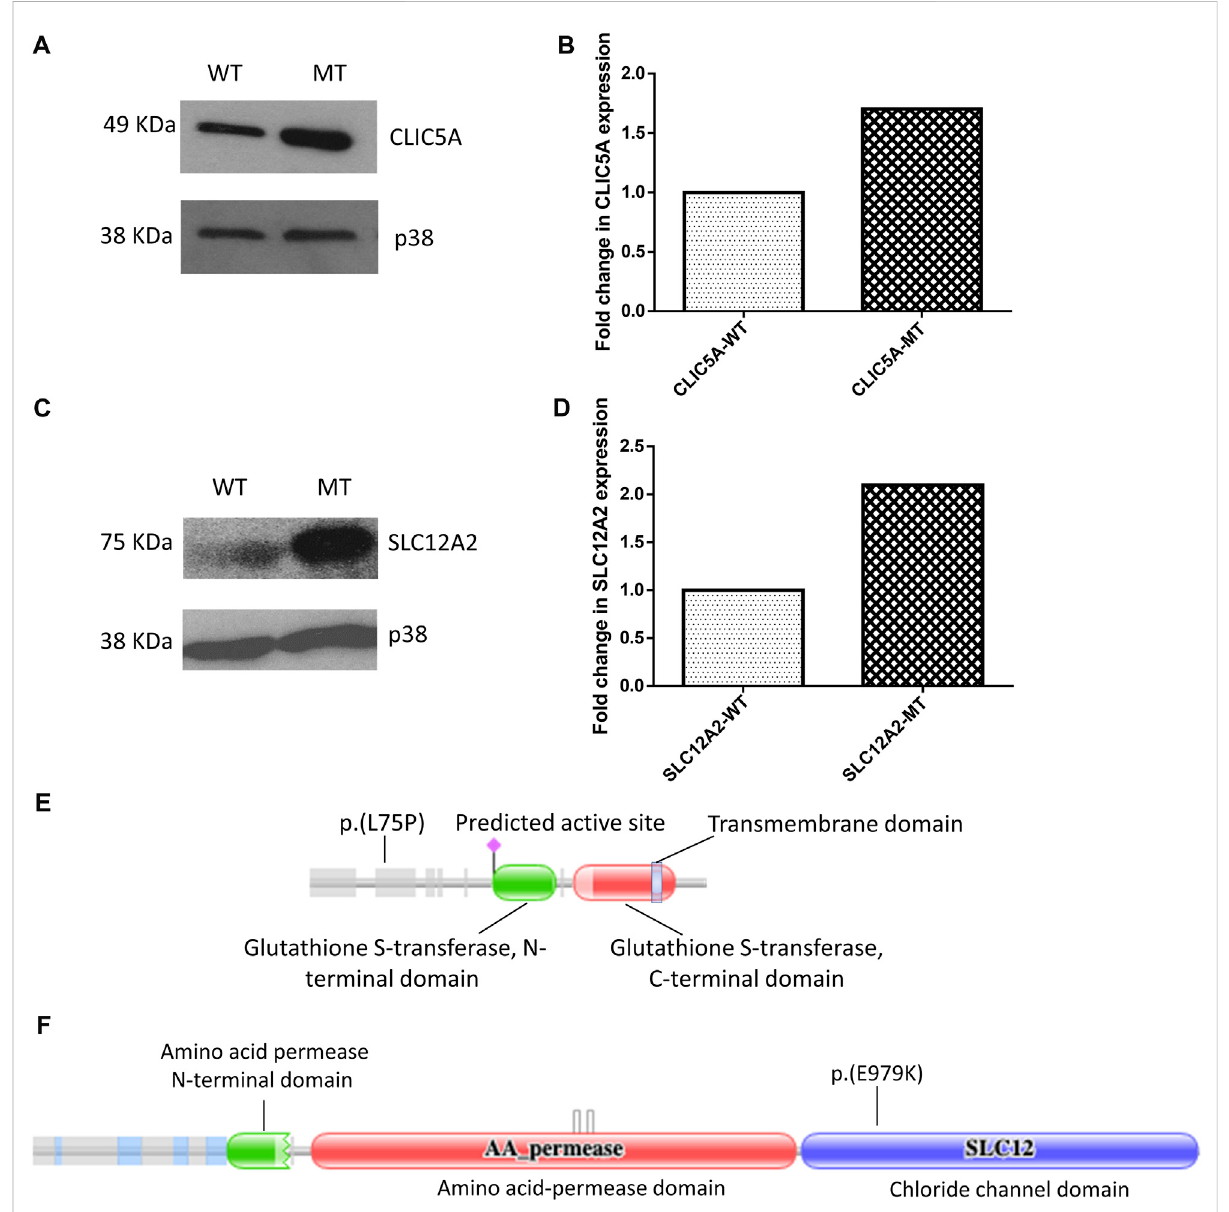
FIGURE 1 Mutant (MT) CLIC5A and SLC12A2 proteins are expressed at higher levels in HEK-293 cells, relative to the wild type proteins (WT). (A) Western blot of total proteins from HEK-293 cells transfected with wild-type (WT) or (C) 224T > C; p.(L75P) mutant (MT) CLIC5A plasmids; using anti-Myc antibody (N-terminal). (B) Densitometric analysis of western blot of CLIC5. (C) Western blot of total protein isolated from HEK-293 cells transfected with WT and (C) 2935G > A:p.(E979K) MT SLC12A2 plasmids;using anti- fl agantibody(N-terminal). (D) Densitometricanalysisofwesternblots of SLC12A2 for the WT and MT SLC12A2 treated cells using ImageJ. The uncropped western blot pictures are shown in Supplementary Figure S3. Schematic diagrams showing (E) CLIC5 p.(L75P) and (F) SLC12A2 p(E979K) variant positions. The protein domains were predicted using the Protein Families Database (Pfam)